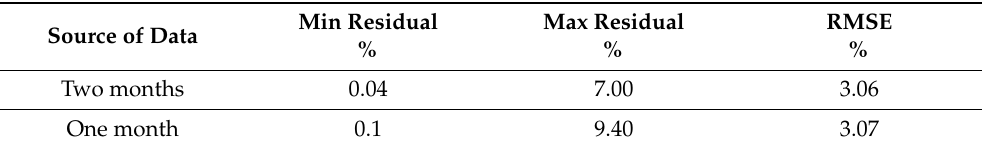
Table 4. Comparison of Min and Max Residuals and Overall RMSE with One and Two Months of Historical Data.